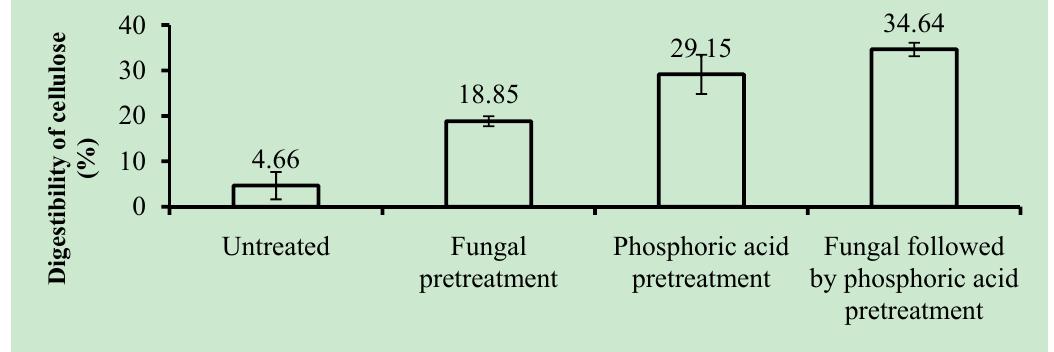
Figure 6. Digestibility of cellulose (%) of oil palm empty fruit bunches (OPEFB) in the enzymatic hydrolysis process (based on initial cellulose content after pretreatments). Error bars are standard